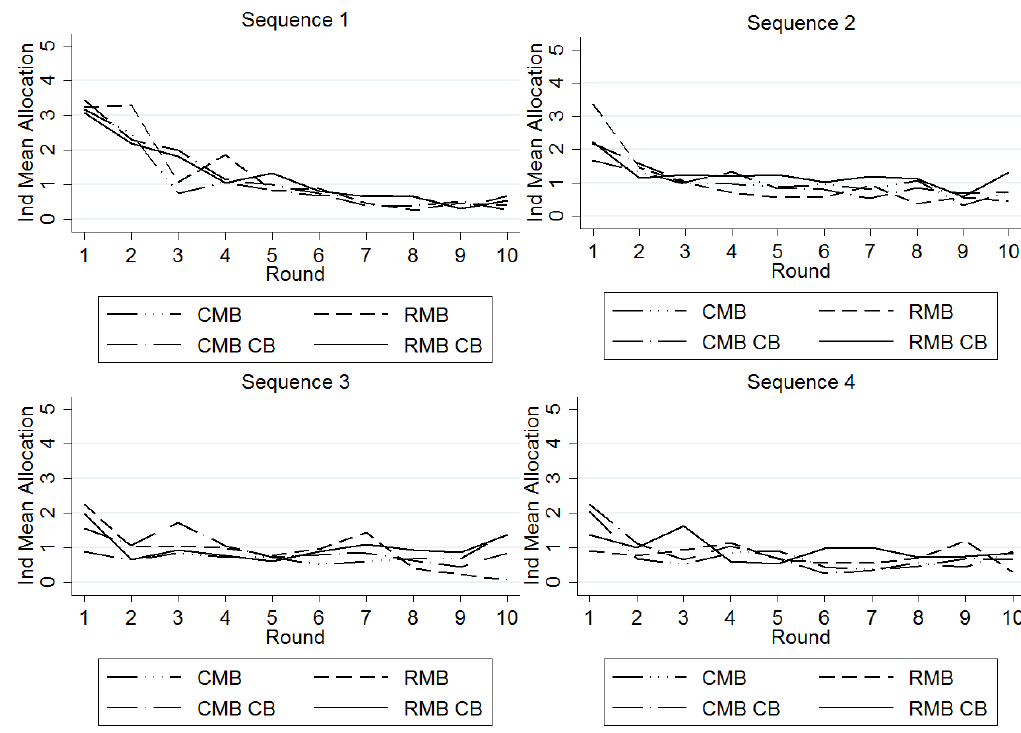
Figure 3. Ind Mean Allocations to the Group Project.